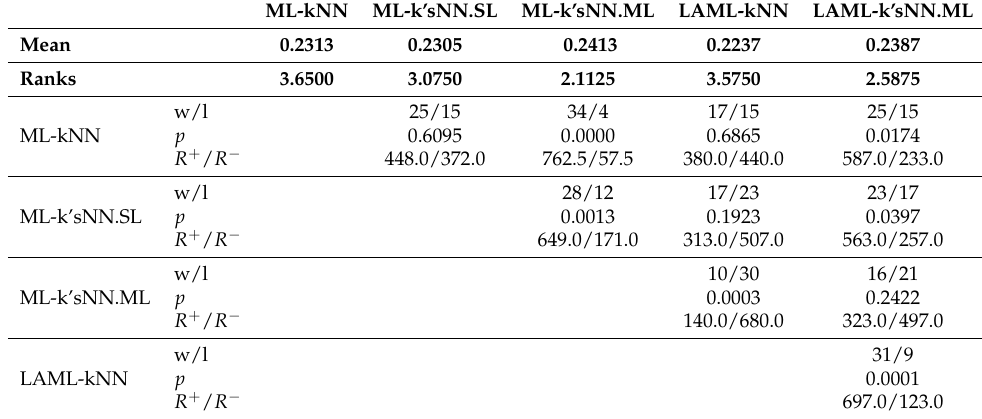
Table 4. Comparison of the different methods using F1 macro metric.